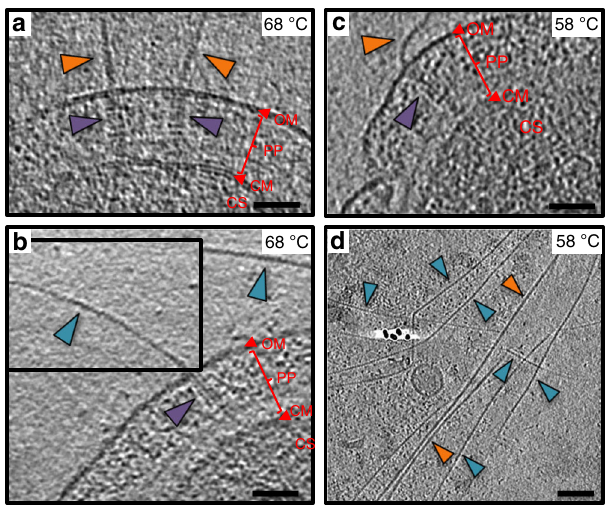
Fig. 1 Thermus assembles two types of pilus. a , b Tomographic slices through T. thermophilus cells grown at 68 °C show both wide (orange arrowheads) and narrow (teal arrowheads) pili emerging from the T4P machinery (purple arrowheads). The pilus emerges from the cell at an acute angle in b , thus the tomographic volume has been rotated to align with the T4P machinery for visualisation (upper inset box). c Tomographic slice through a T. thermophilus cell grown at 58 °C shows a wide pilus (orange arrowhead) emerging from the T4P machinery (purple arrowhead). d Tomographic slice of an area containing many pili from a cell preparation grown at 58 °C. Both wide (orange arrowheads) and narrow pili (teal arrowheads) are visible. OM outer membrane, PP periplasm, CM cytoplasmic membrane, CS Cytosol. Scale bars, 50